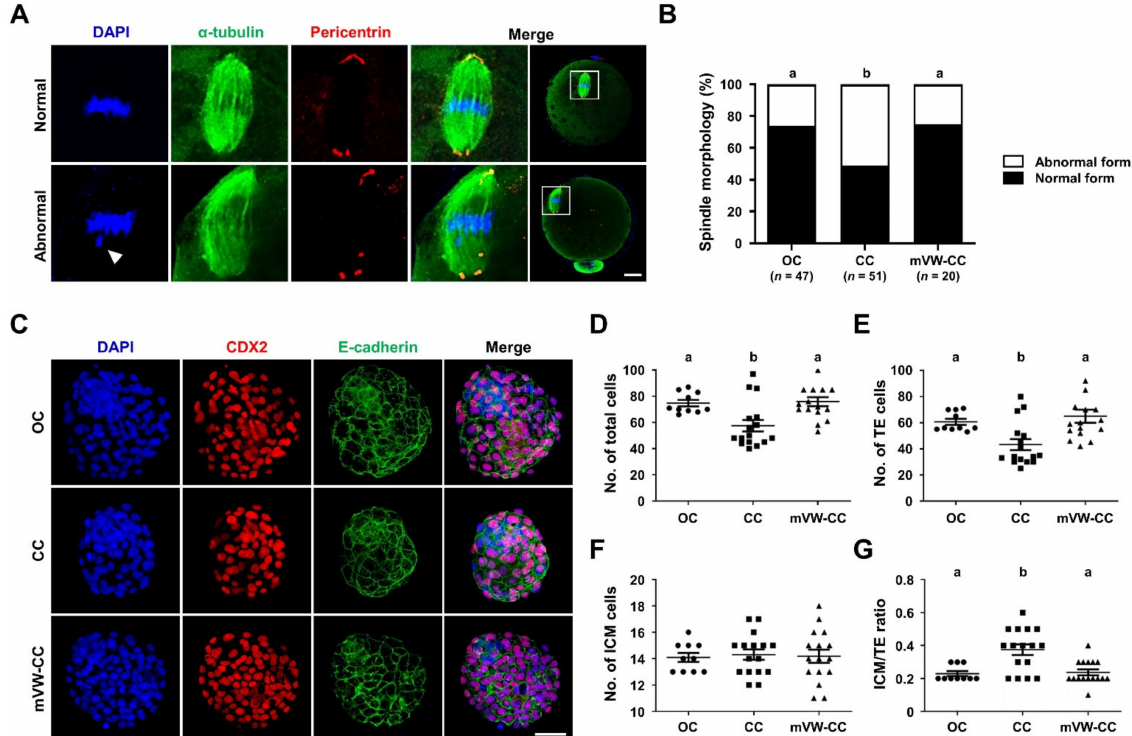
Figure 7. Morphological and functional assays show that the efficacy of vitrified/warned (VW) oocytes in the modified vitrification/warming closed carrier system (mVW-CC) is identical to that in the open carrier system (OC). ( A ) Representative images of immunofluorescence staining for α -tubulin (spindle marker), pericentrin (spindle pole marker), and DAPI (nuclei) in VW oocytes with either normal (upper panels) or abnormal (down panels) meiotic spindle organization and chromosomal alignment. The arrowhead indicates an abnormally aligned chromosome. Scale bar = 20 µ m. ( B ) Quantitative analyses of VW oocytes with normal spindle and chromosome morphologies. White and black bars represent the percentages of oocytes with abnormal and normal spindles, respectively. ( C – G ) Analyses of the blastocyst developed from VW oocytes using mVW-CC. ( C ) Representative images of immunofluorescence staining for CDX2 (trophectoderm (TE) marker) with DAPI in the blastocysts developed from VW oocytes using different vitrification methods. ( D – G ) Quantitative analyses of the total cell number, TE cells, inner cell mass (ICM), and ICM/TE ratio in the blastocysts were done on the basis of the number of DAPI-positive, CDX2-positive, and DAPI-positive and CDX2-negative cells, respectively. The horizontal black lines represent the median values of the total, TE, and ICM cell numbers and ICM/TE ratios. Scale bar = 50 µ m. Different superscript letters (a,b) indicate a significant difference at p < 0.05. The number of oocytes and blastocysts examined = 20–51 ( A , B ) and 10–16 ( C – G ), respectively, in each group. CC, closed carrier